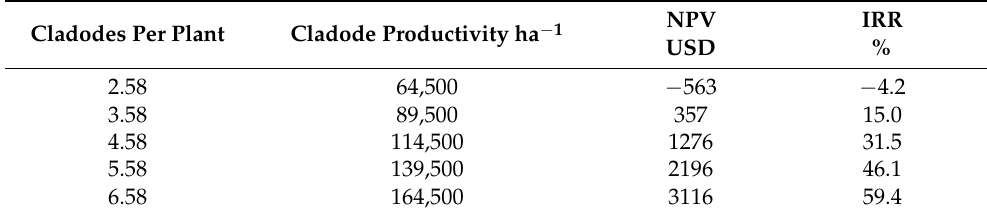
Table 14. NPV and IRR sensitivity for different average cactus plant growth in the Brazilian Northeast production